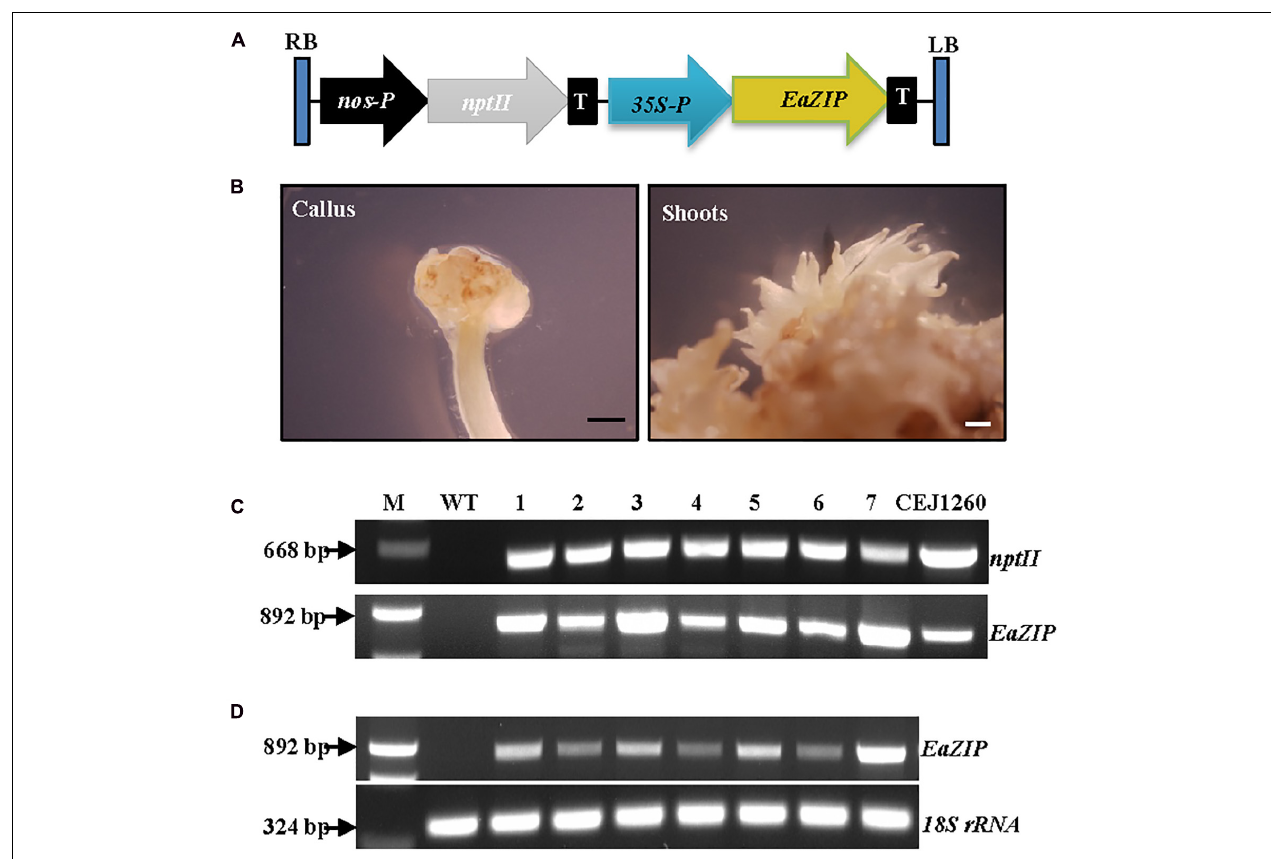
FIGURE 3 | Overexpression of EaZIP in albino plants. (A) Genetic cassette CEJ1260 with EaZIP driven by CaMV35S promoter (35S-P). The remaining annotations are the same as in Figure 2A . (B) Induced calli and shoots. Bar = 1 mm. (C) Genomic DNA PCR and (D) RT-PCR of seven individual transgenic lines (1–7) amplified by specific primer pairs for nptII and EaZIP , respectively, using 18S rRNA as an internal control. M, molecular marker; WT, wild-type albino